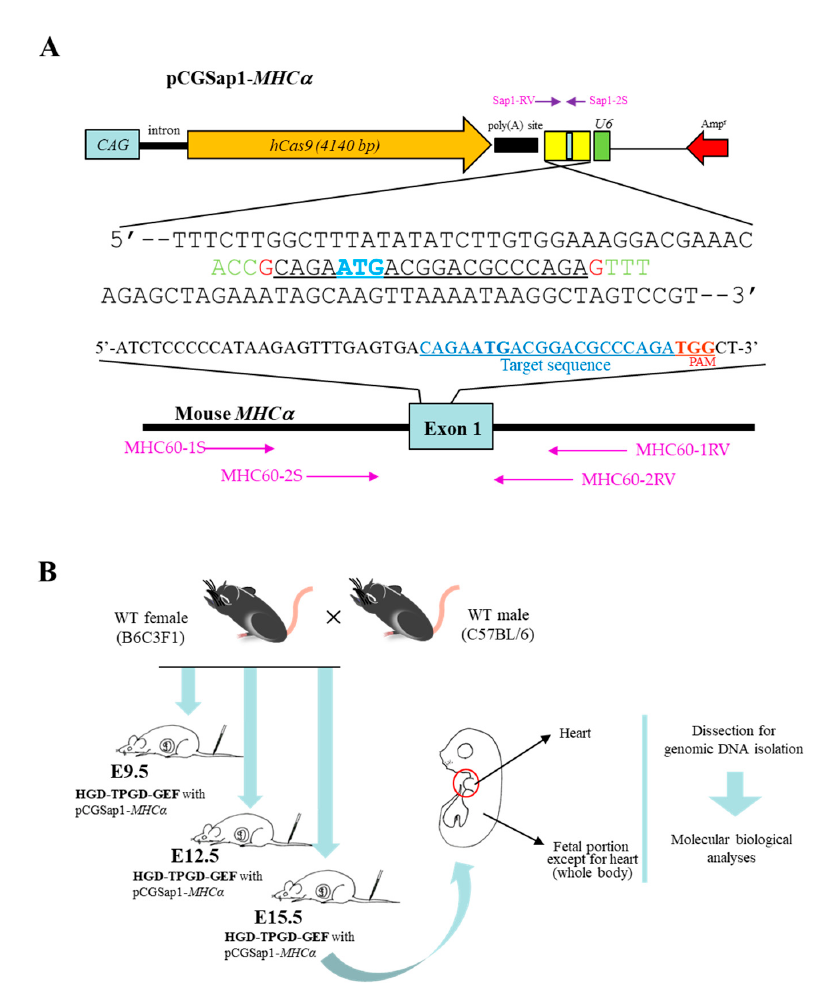
Figure 1. Plasmid used for hydrodynamics-based gene delivery (HGD)-based transplacental gene delivery for acquiring genome-edited fetuses (TPGD-GEF), and a flowchart for experiments using HGD-based TPGD-GEF. ( A ). Structure of pCGSap1 carrying a Cas9 expression unit (comprising CAG ,